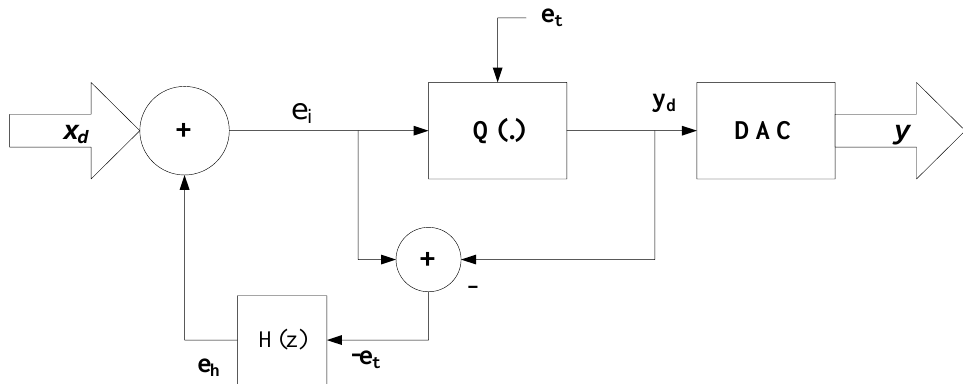
Figure 1. Error Feedback Modulator (EFM) Architecture.